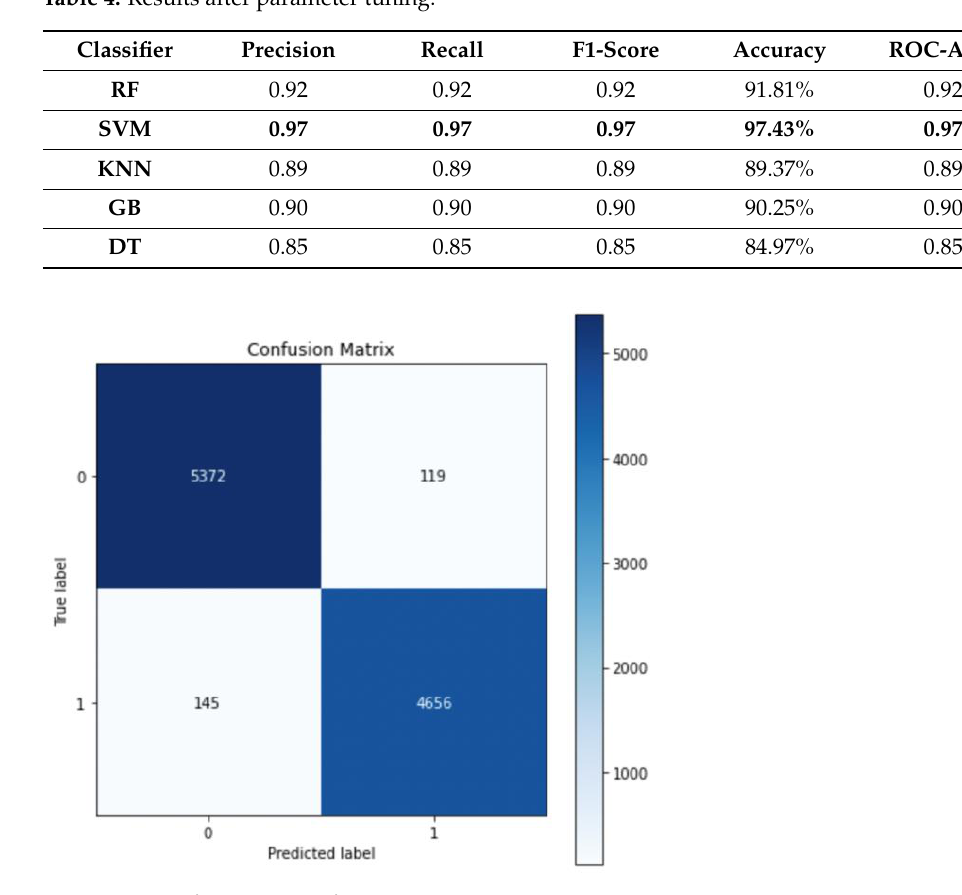
Figure 10. Confusion matrix for SVM. Table 4. Results after parameter tuning.